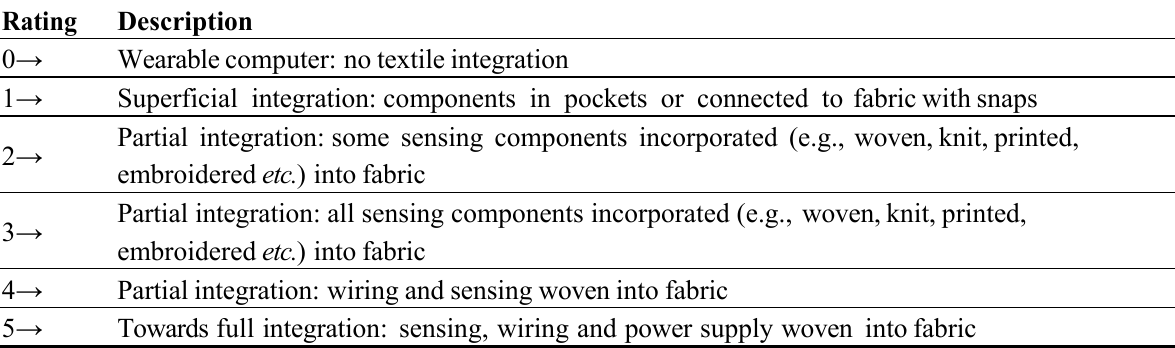
Table 1. Degree of integration.